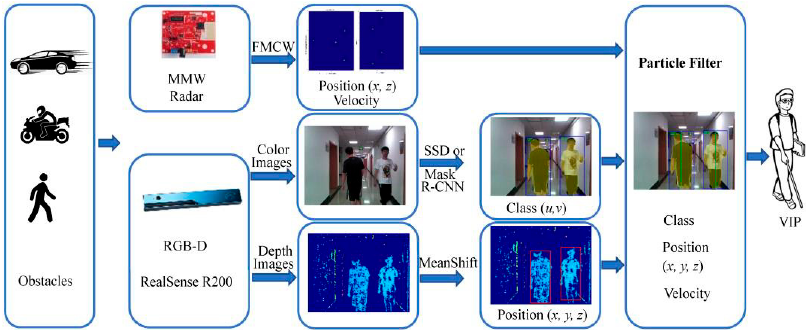
Figure 9. Schematic diagram of the system in [24]. FMCW: frequency-modulated continuous wave.